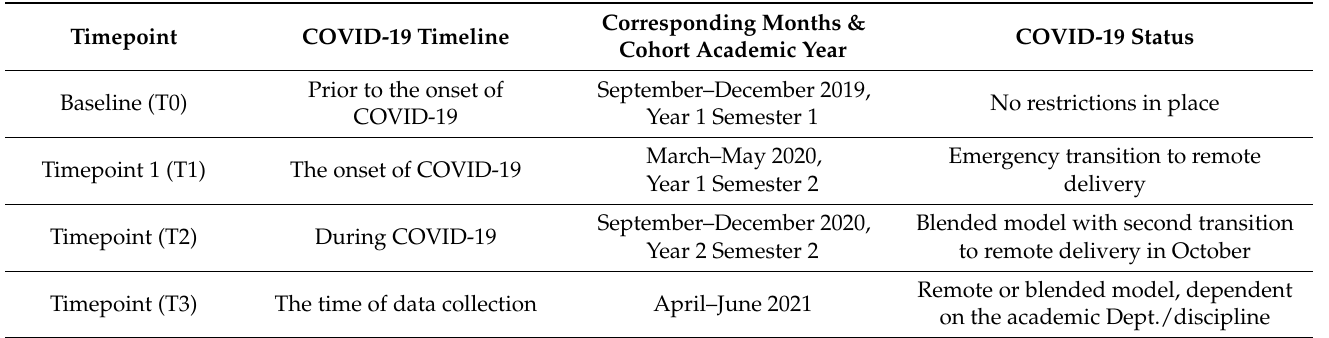
Table 1. Key milestone stages of reporting and participants academic year